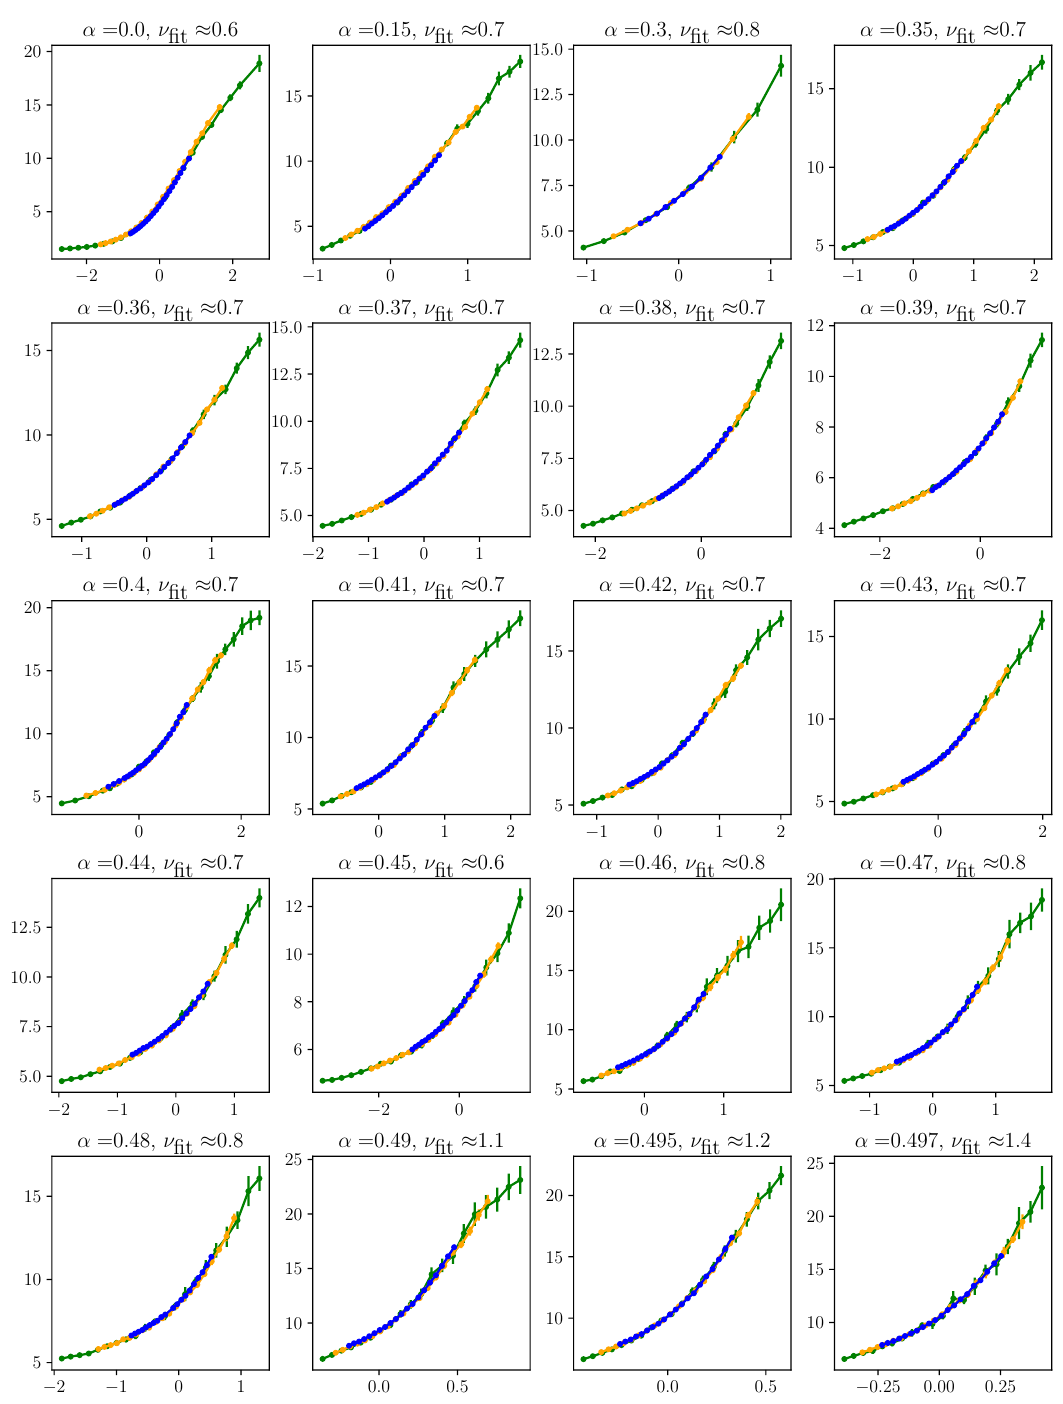
Figure 11: Binder ratio collapse. For each subplot, the Binder ratio B is plotted ) L 1 /ν fit . The best fit values of ν against ( J − J c value of J are used to plot the phase boundary (black line in Fig. c